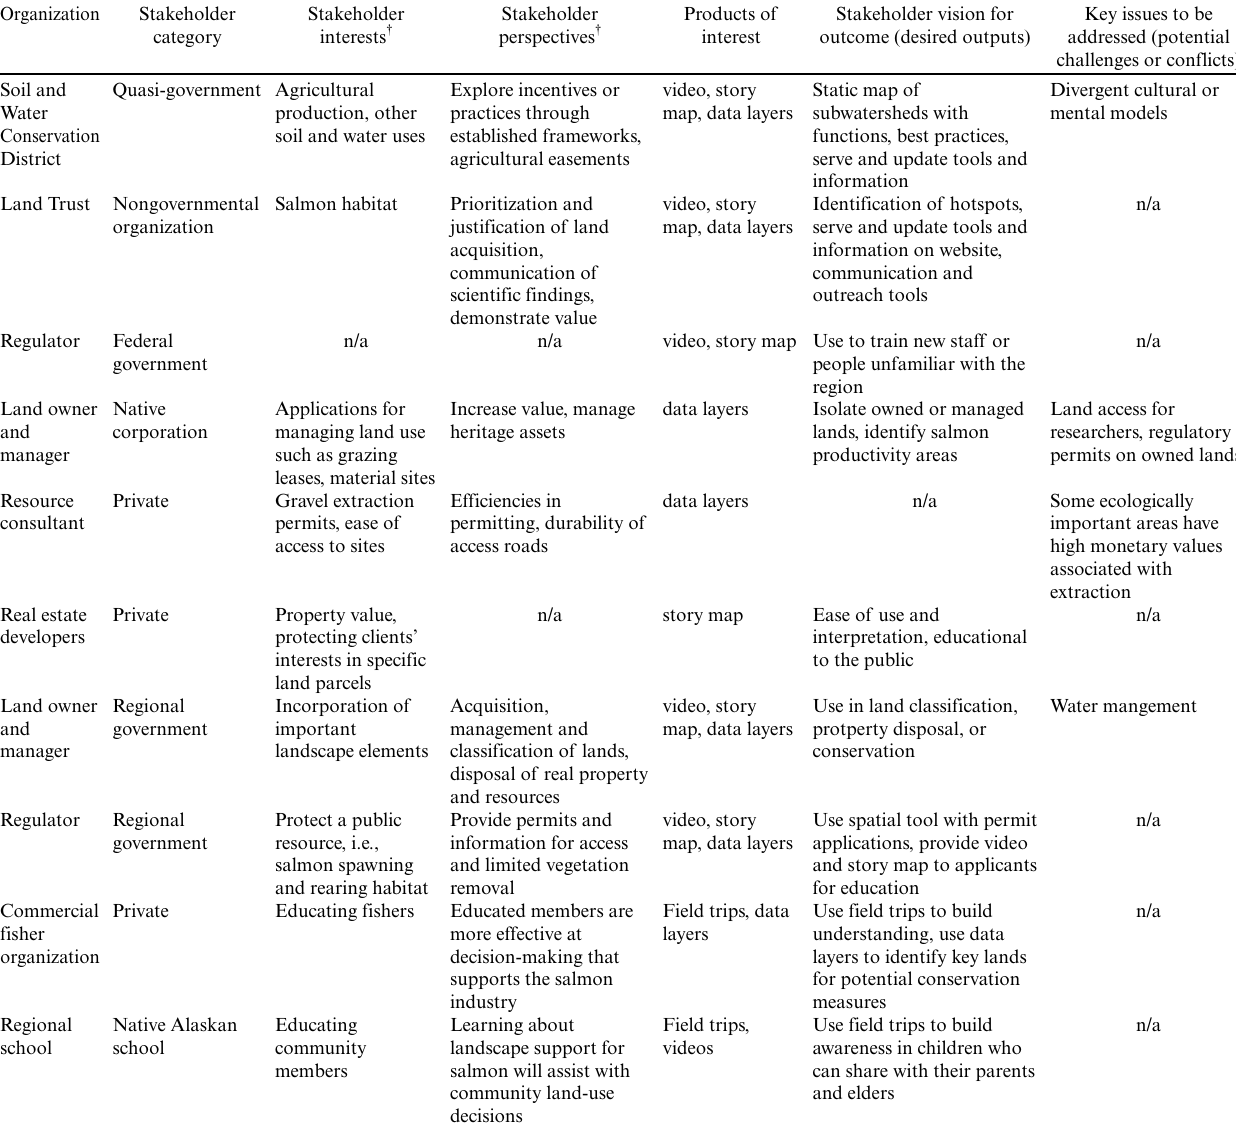
Table 1. Stakeholder engagement opportunities, key interests, products of interest, and desired outcomes in the Kenai Lowlands region, Alaska,